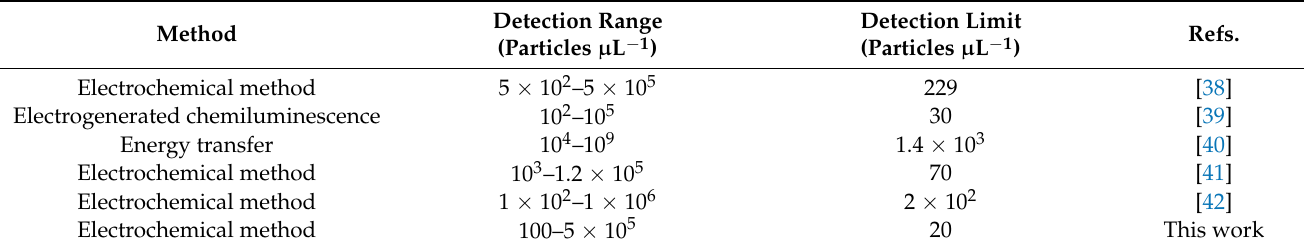
Table 1. Comparison of the response characteristics of various modified electrodes.